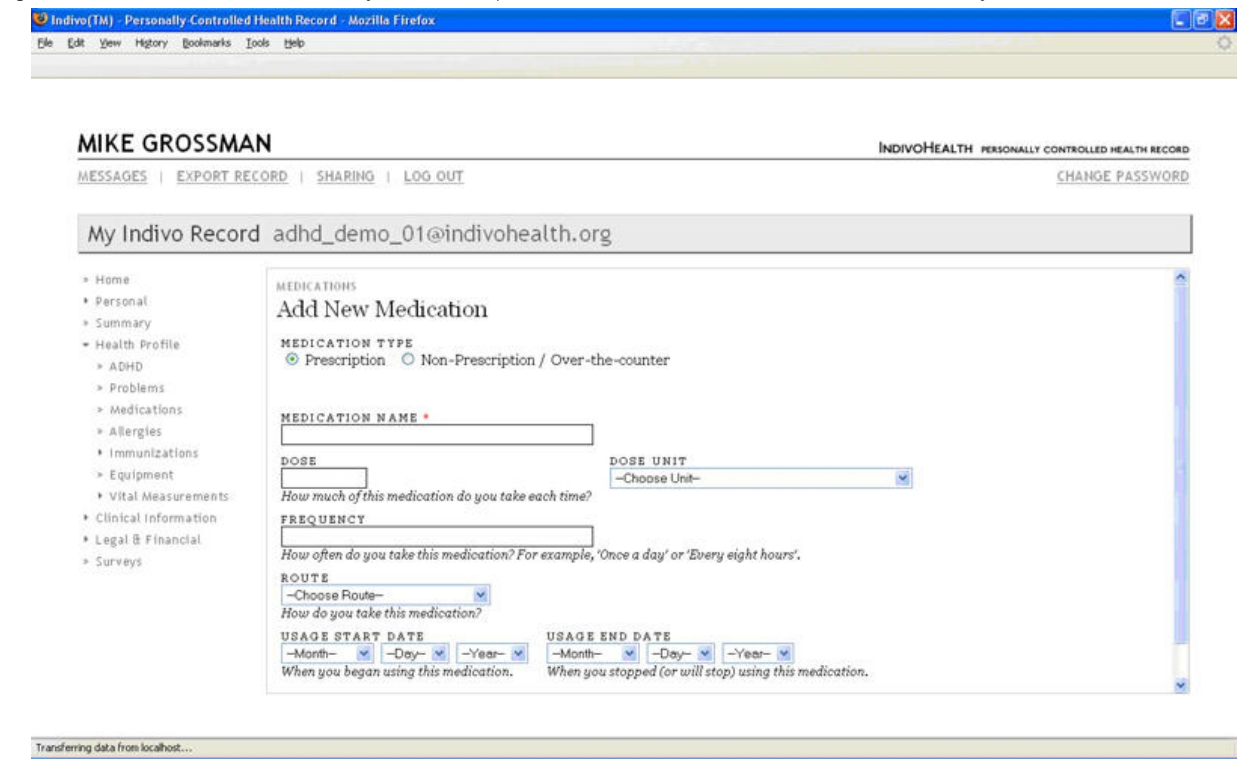
Figure 1. Screenshot from medication entry screen of the prerelease Indivo user-interface used in the heuristic